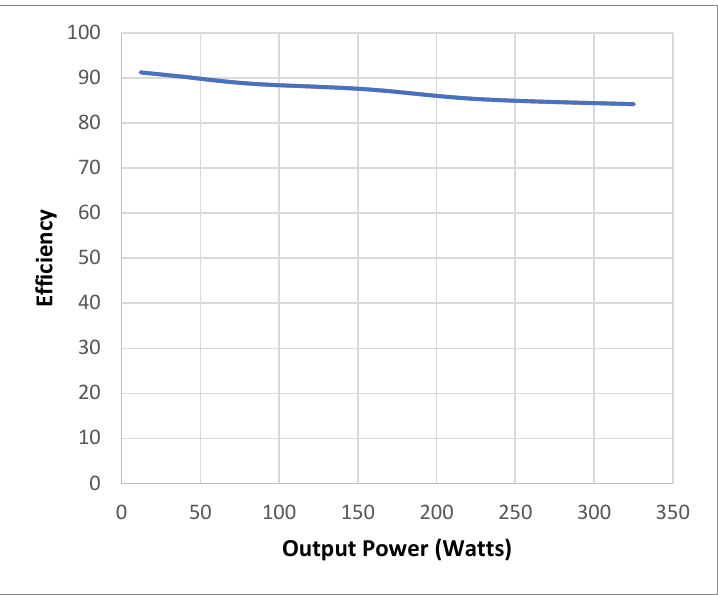
Figure 9. Efficiency versus output power plot of the proposed converter.